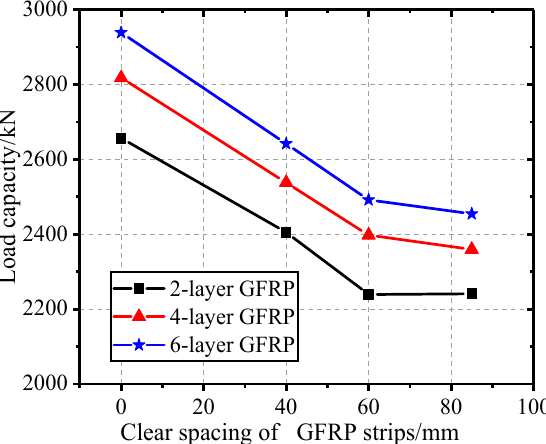
Figure 13. Impact of the clear spacing of the externally wrapped GFRP strips on the load capacity. Table 9. Impact of the wrapping interval of the GFRP strip on the load capacity.